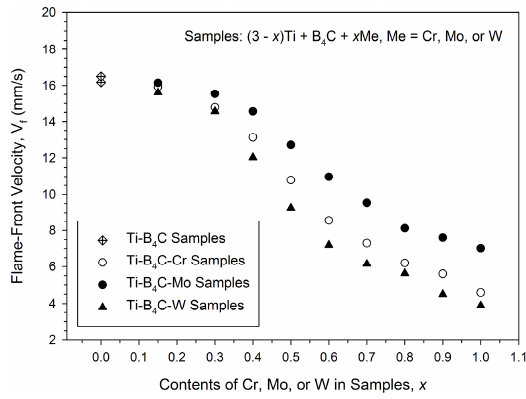
Figure 2. Variations of flame ‐ front velocity with contents of Cr, Mo, and W added into Ti ‐ B 4 C samples.